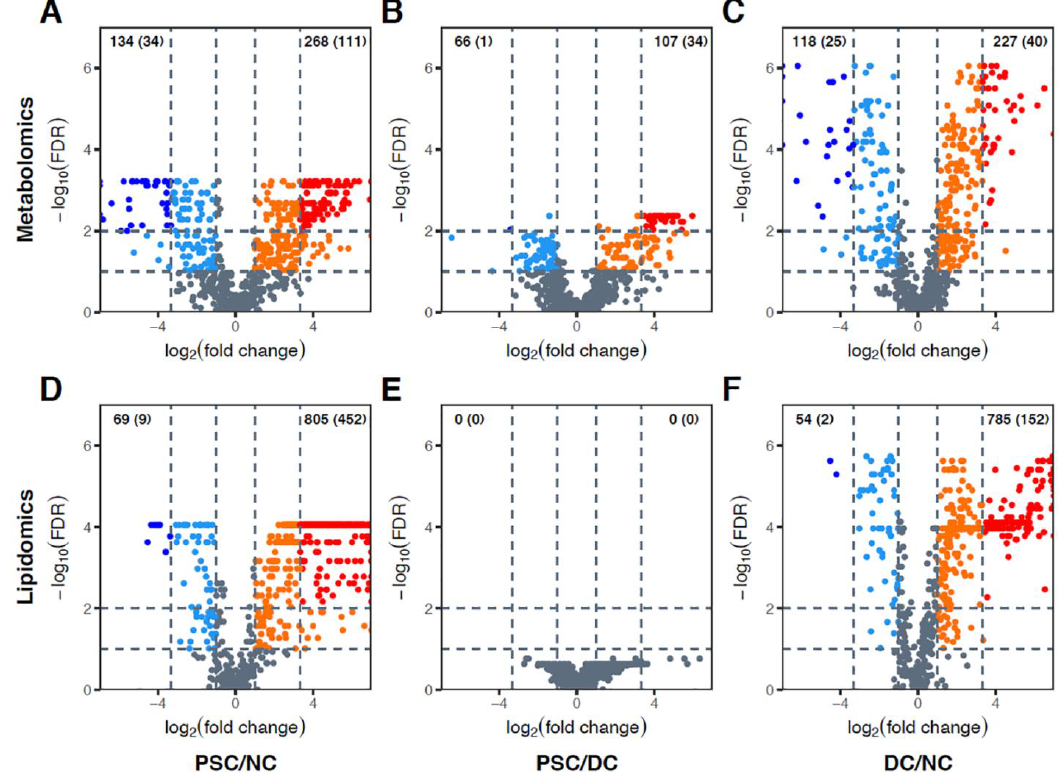
Figure 3. Volcano plots showing differentially abundant metabolites ( A – C ) and complex lipids ( D – F ) in bile. Every possible pair of groups, i.e., PSC versus NC ( A , D ), PSC versus DC ( B , E ), and DC versus NC ( C , F ), were compared. The horizontal axis represents the direction and magnitude of change in relative intensities, and the vertical axis represents statistical significance of the change. Two different thresholds for FC and FDR were used: (i) up- (orange) and downregulated (sky blue) metabolites (FC > 2 and FDR < 0.1); and (ii) very significantly up- (red) and downregulated (blue) metabolites (FC > 10 and FDR < 0.01). Note that very significantly up- and downregulated metabolites are subsets of up- and downregulated metabolites, respectively. Numbers shown in the upper-left and -right corners of each panel represent counts of up- and downregulated metabolites, respectively. Numbers in parentheses represent counts of very significantly up- or downregulated metabolites.